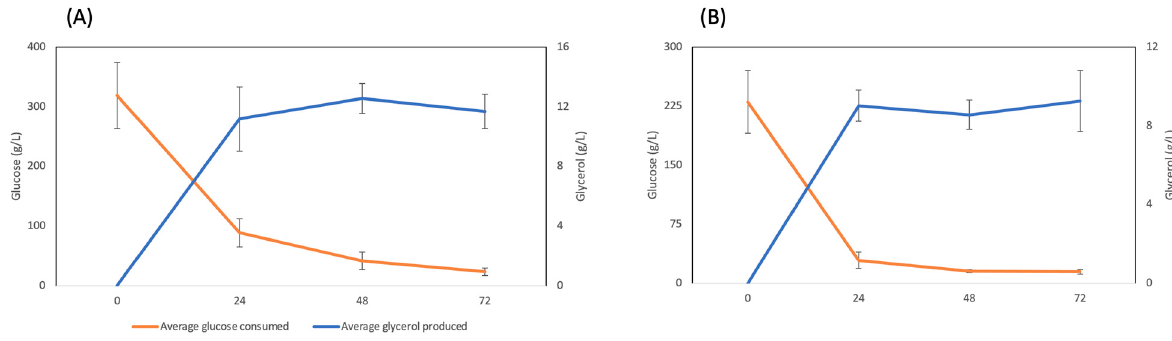
Figure 5. Average consumption of glucose and average production of glycerol for barley ( A ) and oats ( B ).